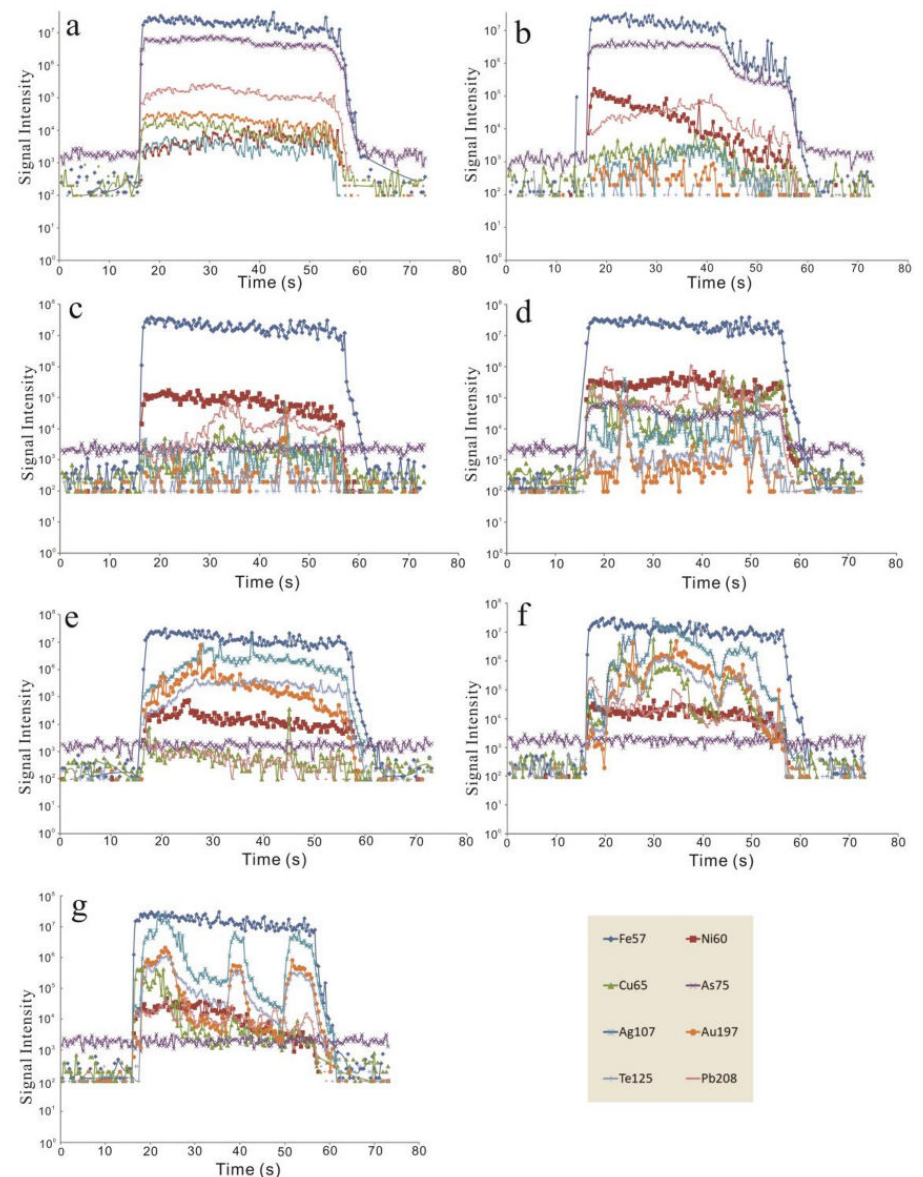
Figure 11. Representative LA-ICP-MS depth–concentration profiles (ion-signal intensity, counts per second) of Au, Ag, Te, Ni, Cu, As and Pb for pyrite grains of different types from the Baiyun gold deposit. The relationship between time and depth is 2.5 µ m of ablation per second. ( a ) The spot in the Py1 pyrite grain contains fewer micro-fractures than sample by-380-1. ( b ) The spot in the Py1 pyrite grain contains more micro-fractures than sample by-380-1. ( c ) Spot analysis of Py2 (away from the micro-fractures) in sample by-160-1-3. ( d ) Py1 spot near micro-fractures in sample by-160-1-3. ( e ), ( f ) and ( g ) Three representative spots in the Py3 grain in sample